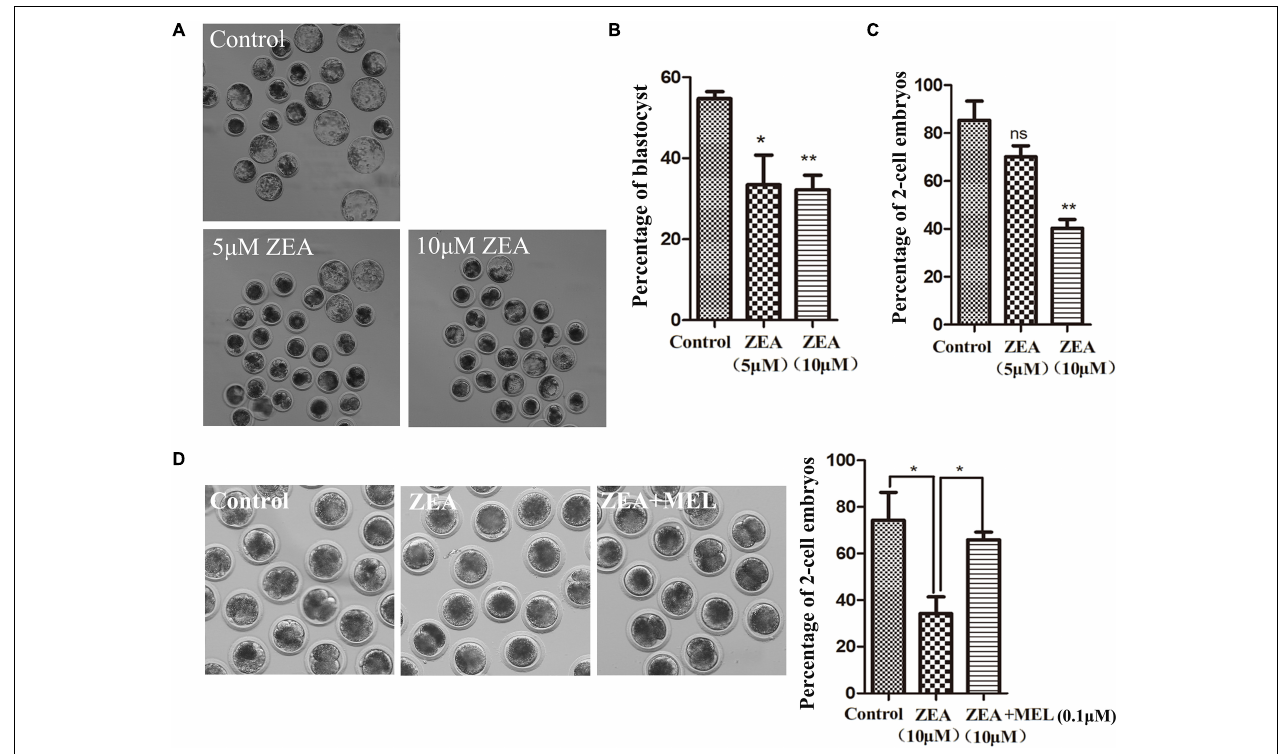
FIGURE 1 | The effect of ZEA on blastocyst and 2-cell formation and protective effect of melatonin. (A) Representative images of blastocyst formation in control group and ZEA treatment group with different concentrations. (B) Blastocyst percent recorded in control group and ZEA treatment group. Data were presented as mean percentage ± SEM from at least three independent experiments. ∗ P < 0.05 and ∗∗ P < 0.01. (C) Percentage of 2-cell in control and different concentrations ZEA treatment groups. (D) Representative images of 2-cell formation in control, ZEA-exposed, and ZEA+MEL groups. Percentage of 2-cell in control, ZEA-exposed, ZEA+MEL groups. Data were presented as mean percentage ± SEM from at least three independent experiments. ∗ P < 0.05 and ∗∗ P <